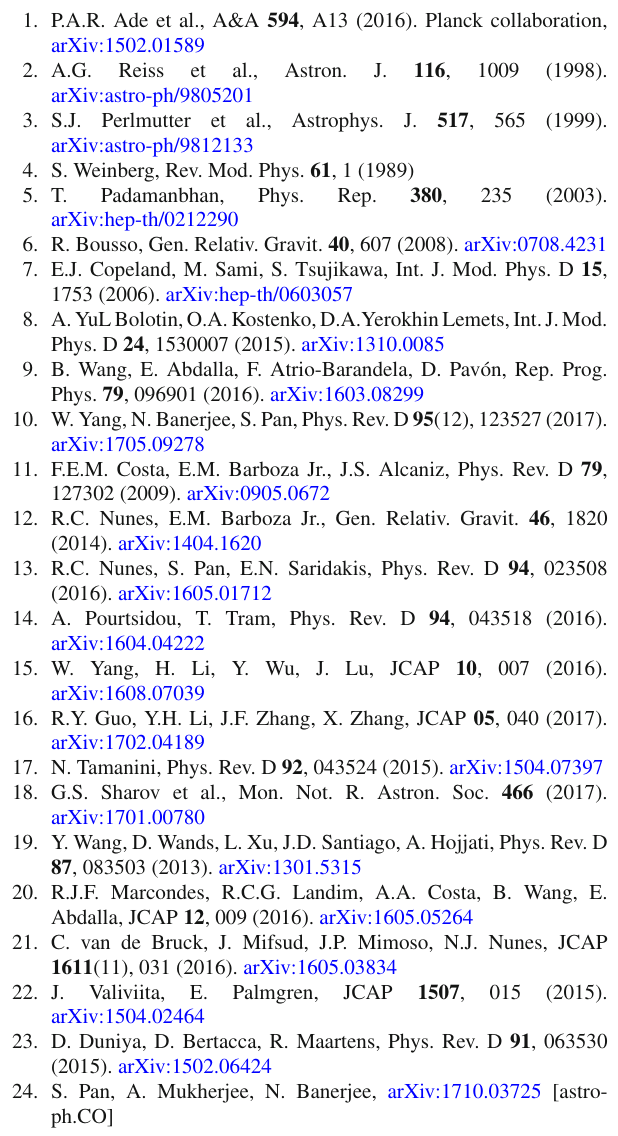
Fig. 4 Relative deviation of matter power spectrum from the base line Planck 2015 (cid:3) CDM model (red line) for various values of ξ while the other parameters are fixed to their best-fit mean values as given in Table